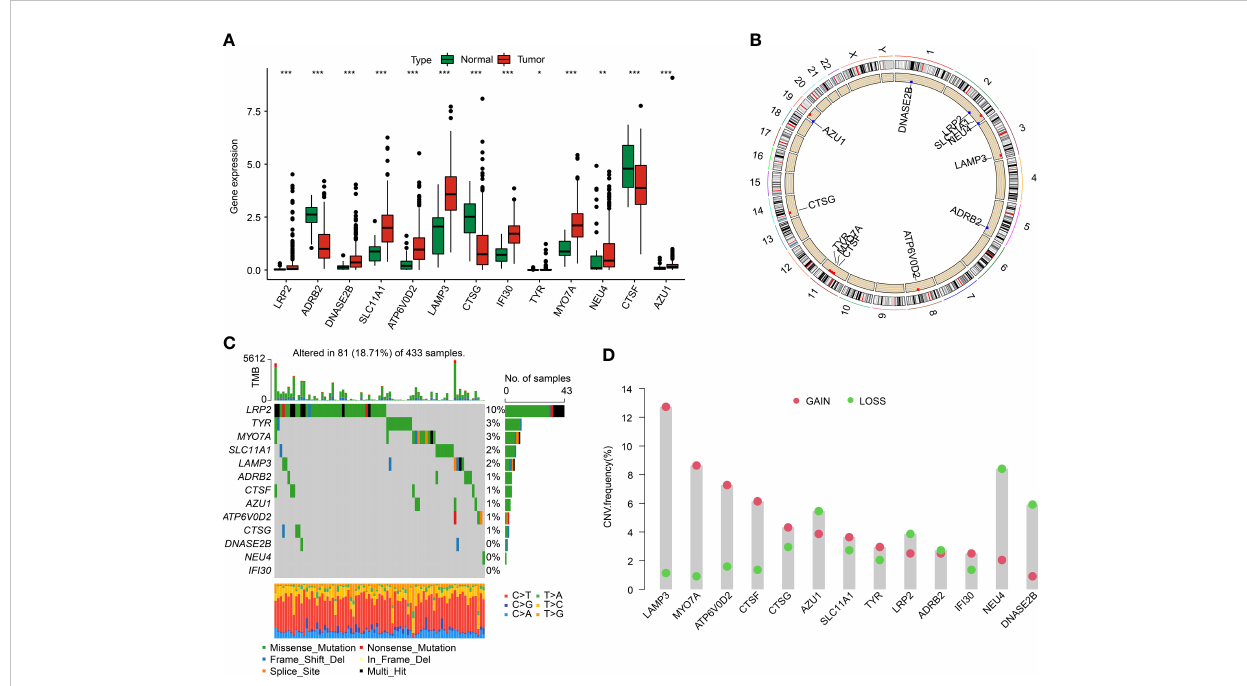
FIGURE 1 Differential expression analysis and somatic mutation feature of LYRGs in GC. (A) The differential expression analysis of LYAGs in normal and tumor tissues from TCGA. (B) Position of LYAGs on chromosome. (C) Genetic mutation characteristics of LYAGs in GC from GSE84437. (D) The CNV of LYAGs. *p < 0.05, **p < 0.01, ***p <